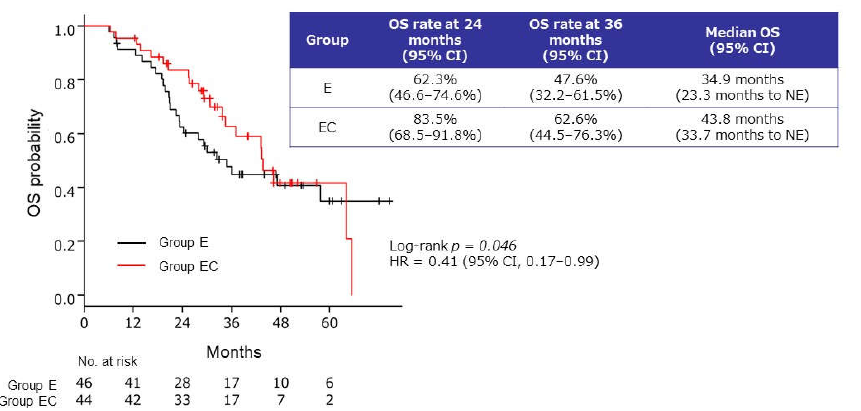
Figure 4. Kaplan–Meier curves of time to failure of strategy (TFS) from randomization in patients who received bevaci- zumab–paclitaxel reinduction therapy after maintenance therapy with endocrine therapy alone (group E) or endocrine therapy plus capecitabine (group EC). CI, confidence interval; E, endocrine therapy alone; EC, endocrine therapy plus capecitabine.